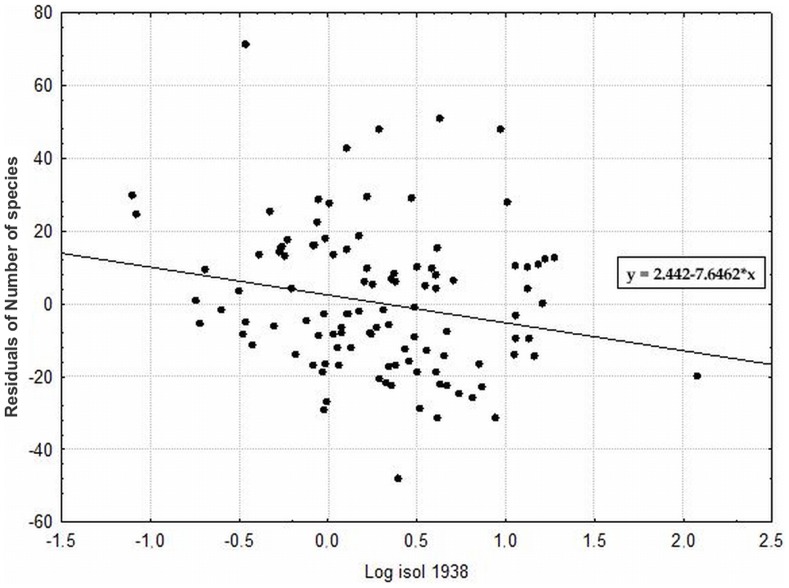
The effect of historical isolation in 1938 on species richness.(depicted as residuals of number of species with coordinates as covariates). The outlier values for the number of species have localities with currently higher species richness regardless of their isolation in the past, and the outlier value in isolation has a locality that was much more isolated from other localities in the past and also in the present. P = 0.0325; r = −0.232.